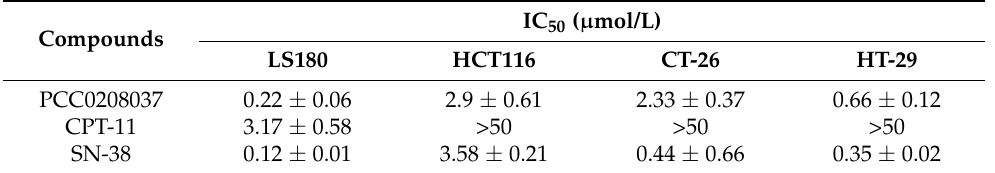
Table 1. The inhibitory effects of PCC0208037 on CRC cells ( n = 3). Compounds